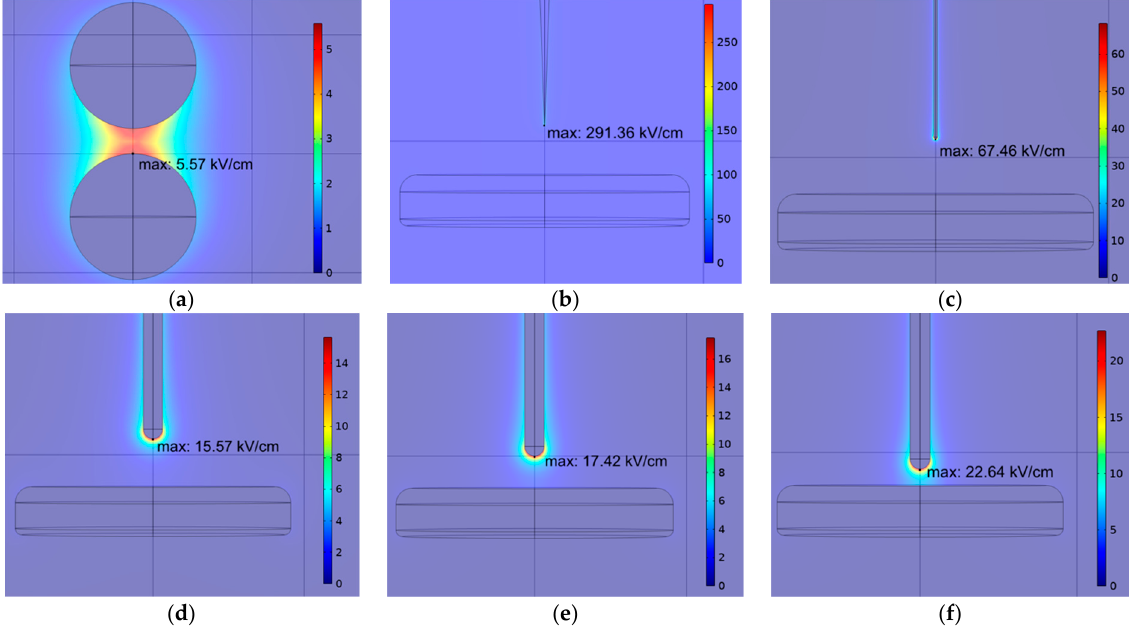
Figure 20. The maximum electric field and electric field distribution for different electrode systems: ( a ) sphere–sphere (d = 10 mm); ( b ) needle–plane (d = 15 mm); ( c ) rod (R = 1 mm)–plane (d = 15 mm); ( d ) rod (R = 6 mm)–plane (d = 15 mm); ( e ) rod (R = 6 mm)–plane (d = 10 mm); ( f ) rod (R = 6 mm)–plane (d = 5